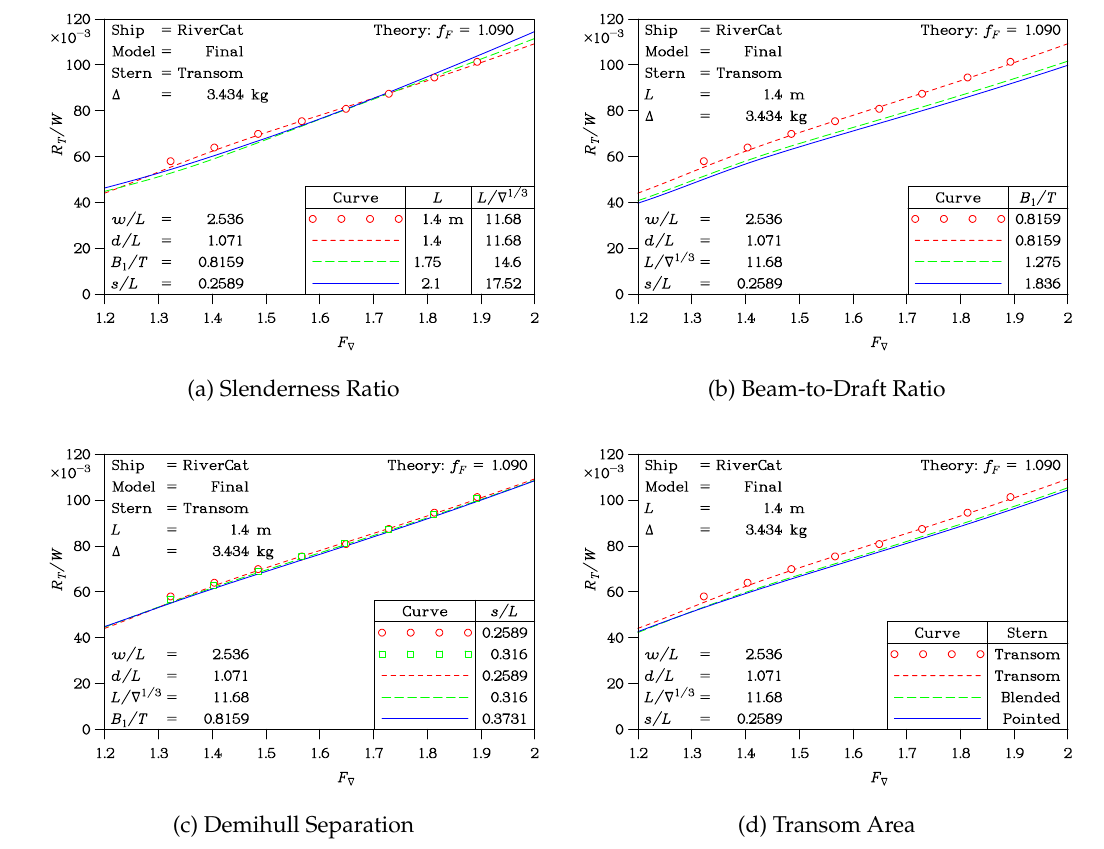
Figure 10. Influence of Affine Transformations on Model Resistance